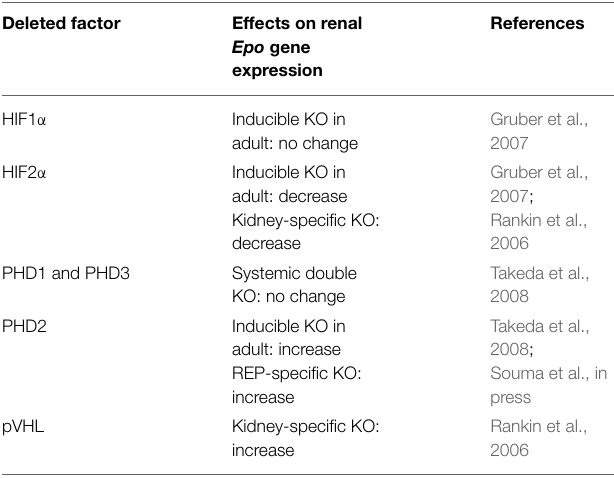
TABLE 1 | Summary of gene targeting studies of hypoxia-related factors on renal Epo gene